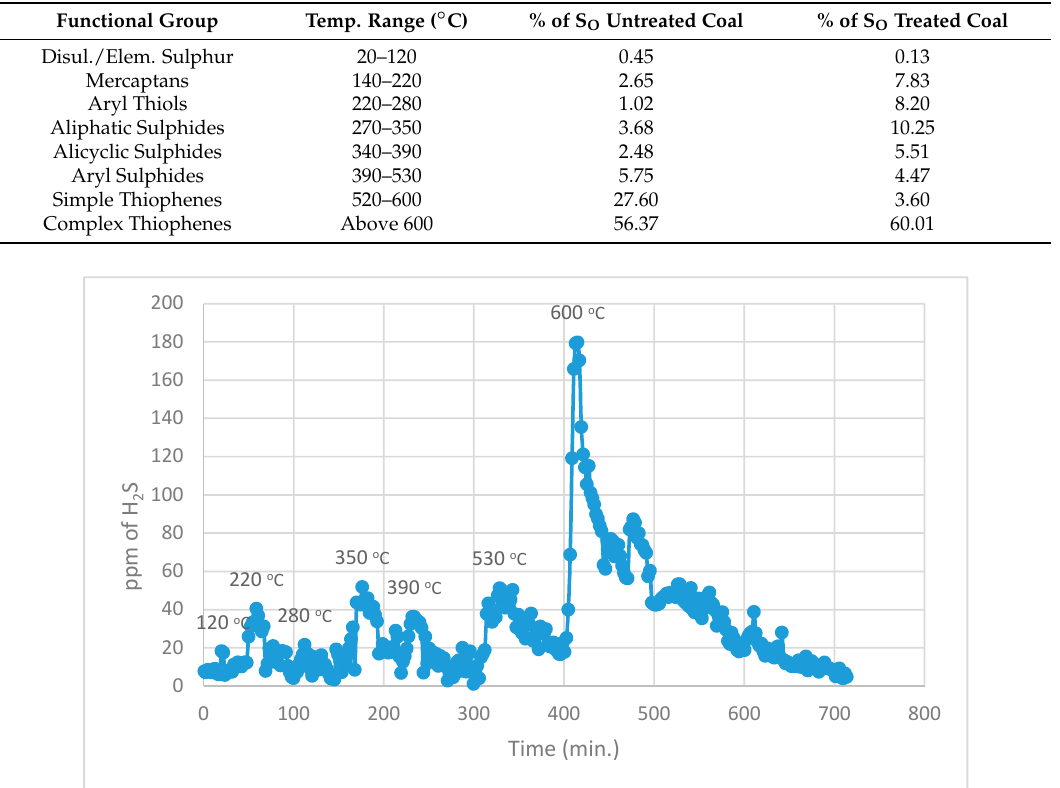
Figure 4. TPR of untreated silverdale coal.